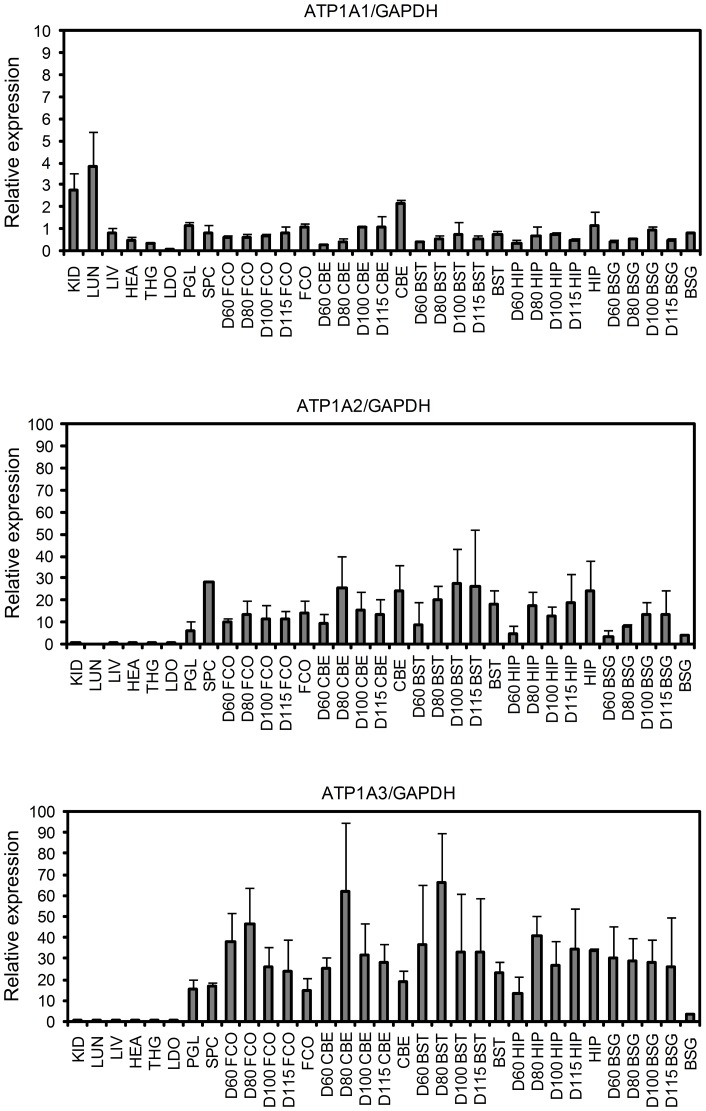
Relative expression pattern of porcine ATP1A1, ATP1A2, and ATP1A3 mRNA in different organs and tissues from adult pigs and from brain tissues at different stages of embryonic development.
GAPDH is used as endogenous reference. Each column represents the mean expression of a triplicate from three different pigs. The considerable biological variation between the animals represented in each column is indicated by error bars showing the standard deviation. KID: kidney, LUN: lung, LIV: liver, HEA: heart, THG: thyroid gland, LDO: longissimus dorsi, PGL: pituitary gland, SPC: spinal cord, FCO: frontal cortex, CBE: cerebellum; BST: brain stem, HIP: hippocampus, BSG: basal ganglia, D60: embryo of day 60, D80: embryo of day 80, D100: embryo of day 100, D115: embryo of day 115.